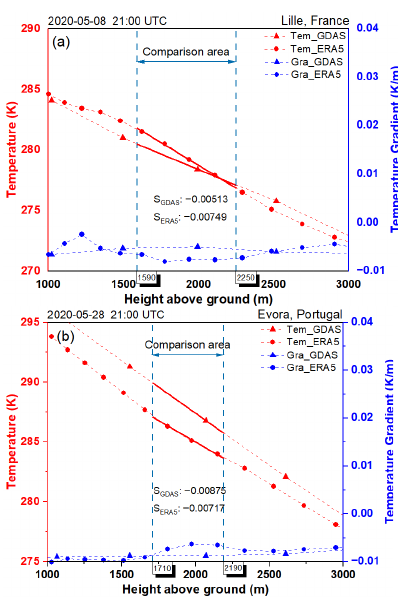
Figure 8. ( a ) The relationship between the mean relative deviation of extinction and aerosol load; ( b ) The relationship between the mean relative deviation of extinction and the mean relative devia- tion of the gradient of molecular number density; ( c ) The relationship between the mean absolute deviation of the molecular number density gradient and the mean absolute deviation of the temper- ature gradient. The red lines shown in the subfigure indicate the linear fit curve, of which the equa- tions are also reported, being x and y the variables of the axes.